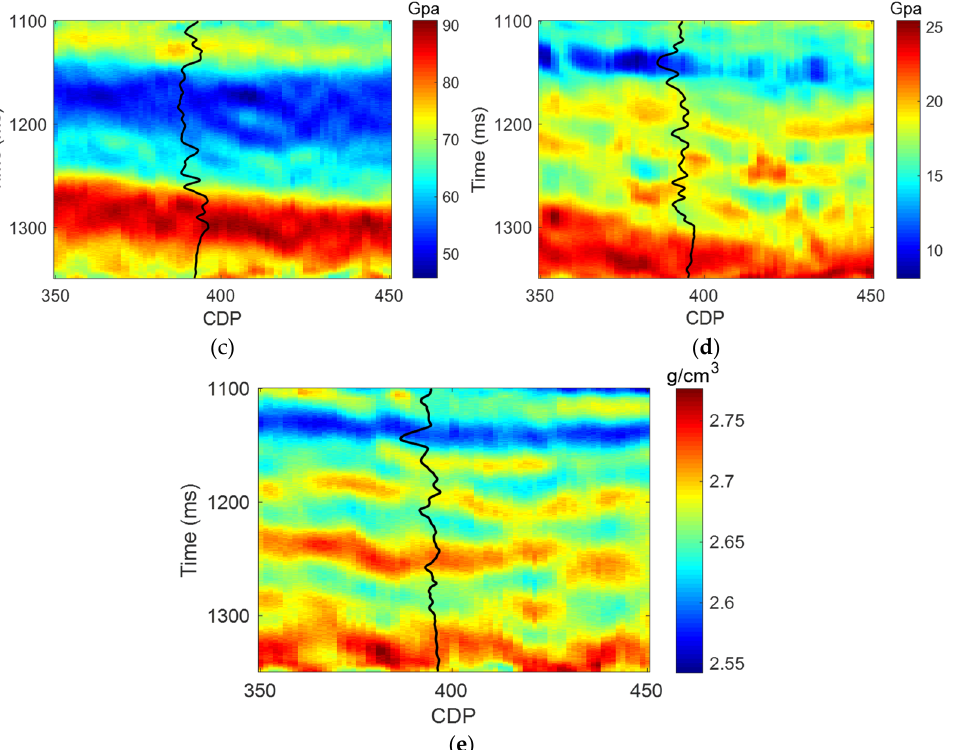
Figure 15. Inversion pro fi les of ( a ) c 33 , ( b ) c 55 , ( c ) c 11 , ( d ) c 13 , and ( e ) ρ , by using the Rüger approxima- tion based linear optimization in the fi rst step of the sequential method. The corresponding well logs are given.